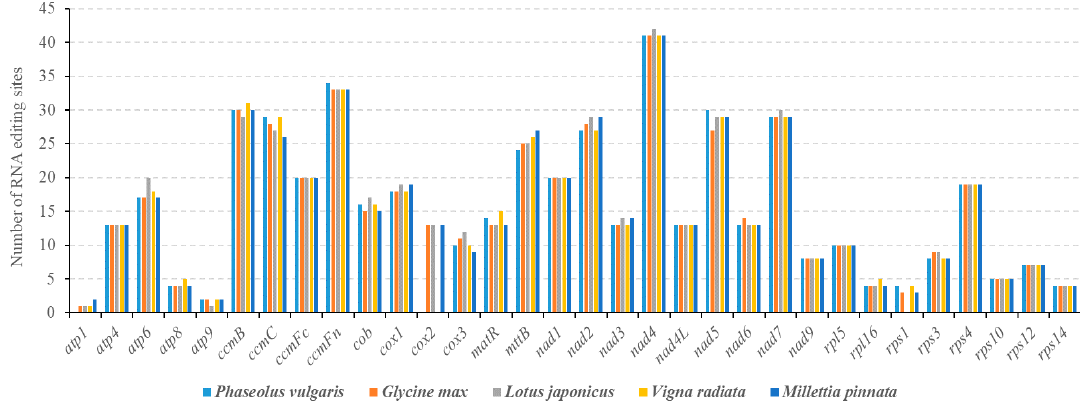
Figure 6. Predicted RNA editing sites of the P. vulgaris mitogenome compared with four other leguminous plants. RNA-editing sites are predicted on PREP-Mt sites (http://prep.unl.edu/) with the cut-off value of 0.2.